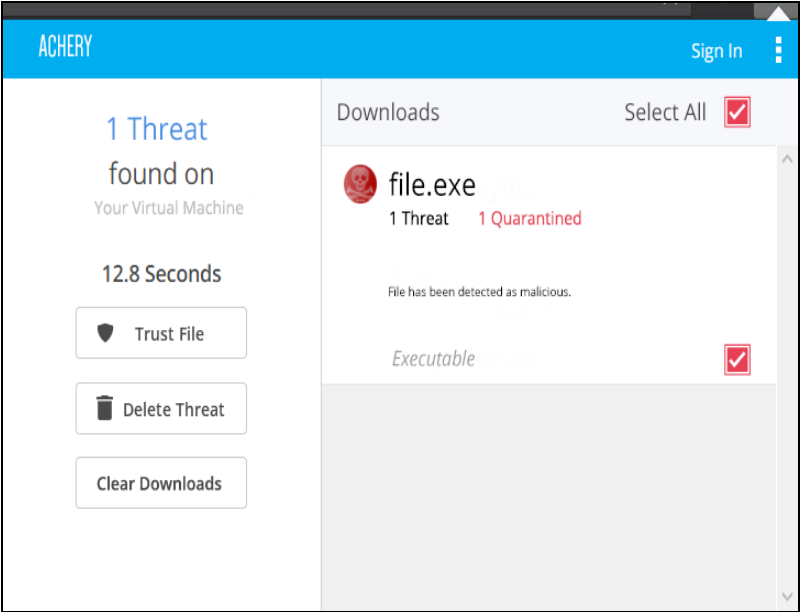
Fig. 3. Browser Extension Mockup (After